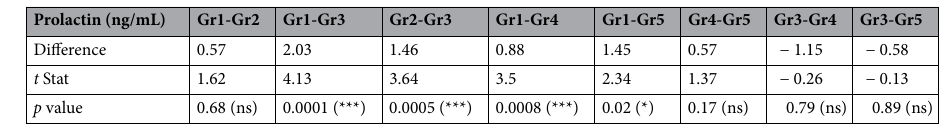
Table 3. Results of statistical analysis (paired t test) between different groups of Phase 2 study. Gr group.